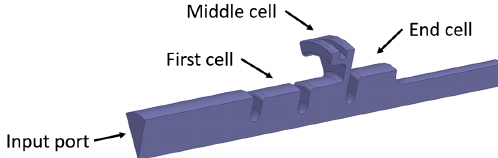
FIG. 1. HFSS model of choke-mode accelerating structure.